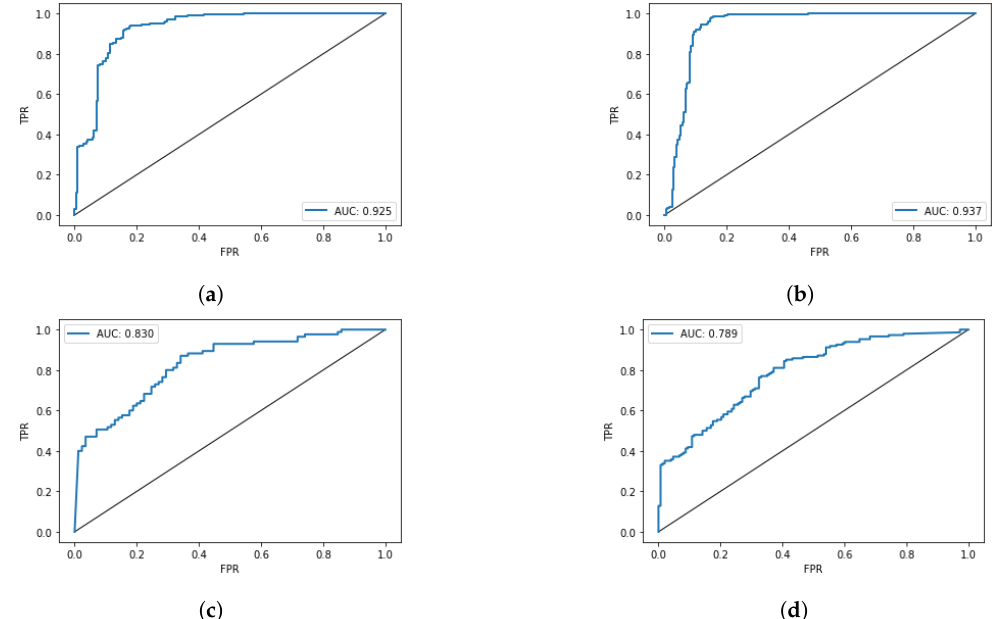
Figure 3. Membership Inference Attack on different models. ( a ) MIA on the model with the best accuracy without FL. ( b ) MIA on the model with the best accuracy with FL and without DP. ( c ) MIA on the model with the best accuracy with FL and DP 25 epochs. ( d ) MIA on the model with the best accuracy with FL and DP 50